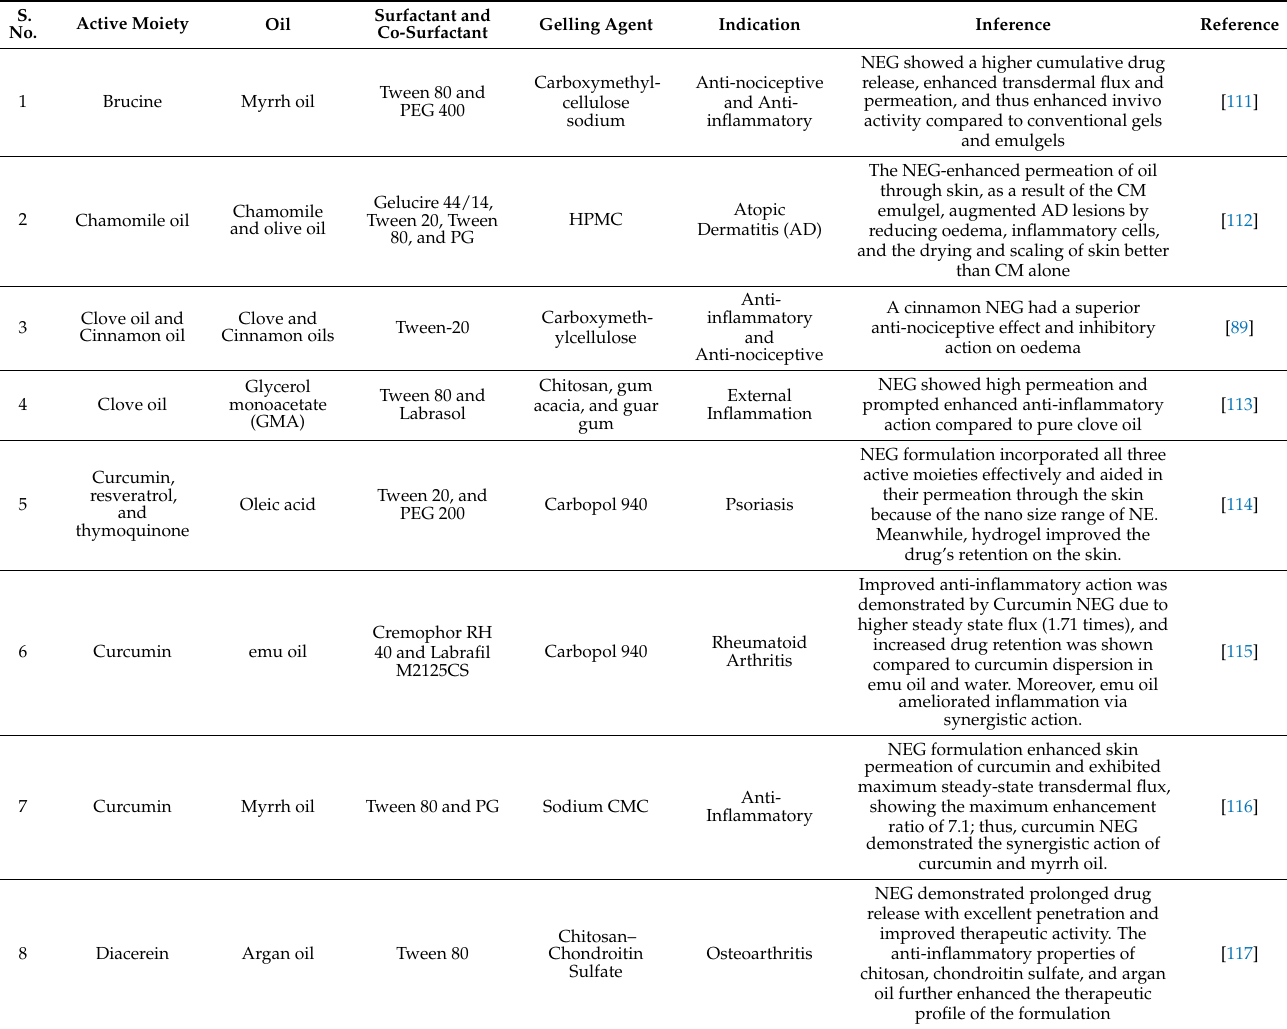
Table 2. Herbal drug-loaded nanogels for anti-inflammatory